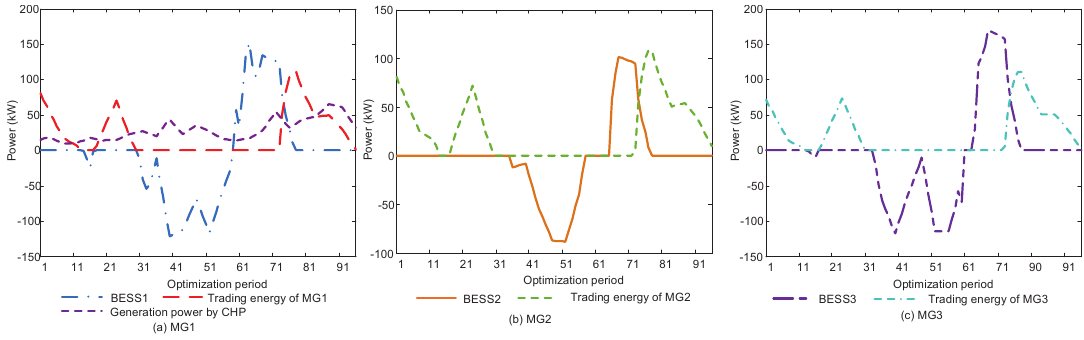
Figure 22. The generated power of combined heat and power (CHP), the output power of BESSs and the power purchased from the main grid of each MG in Scenario 2 (( a ) MG1; ( b ) MG2; ( c ) MG3).